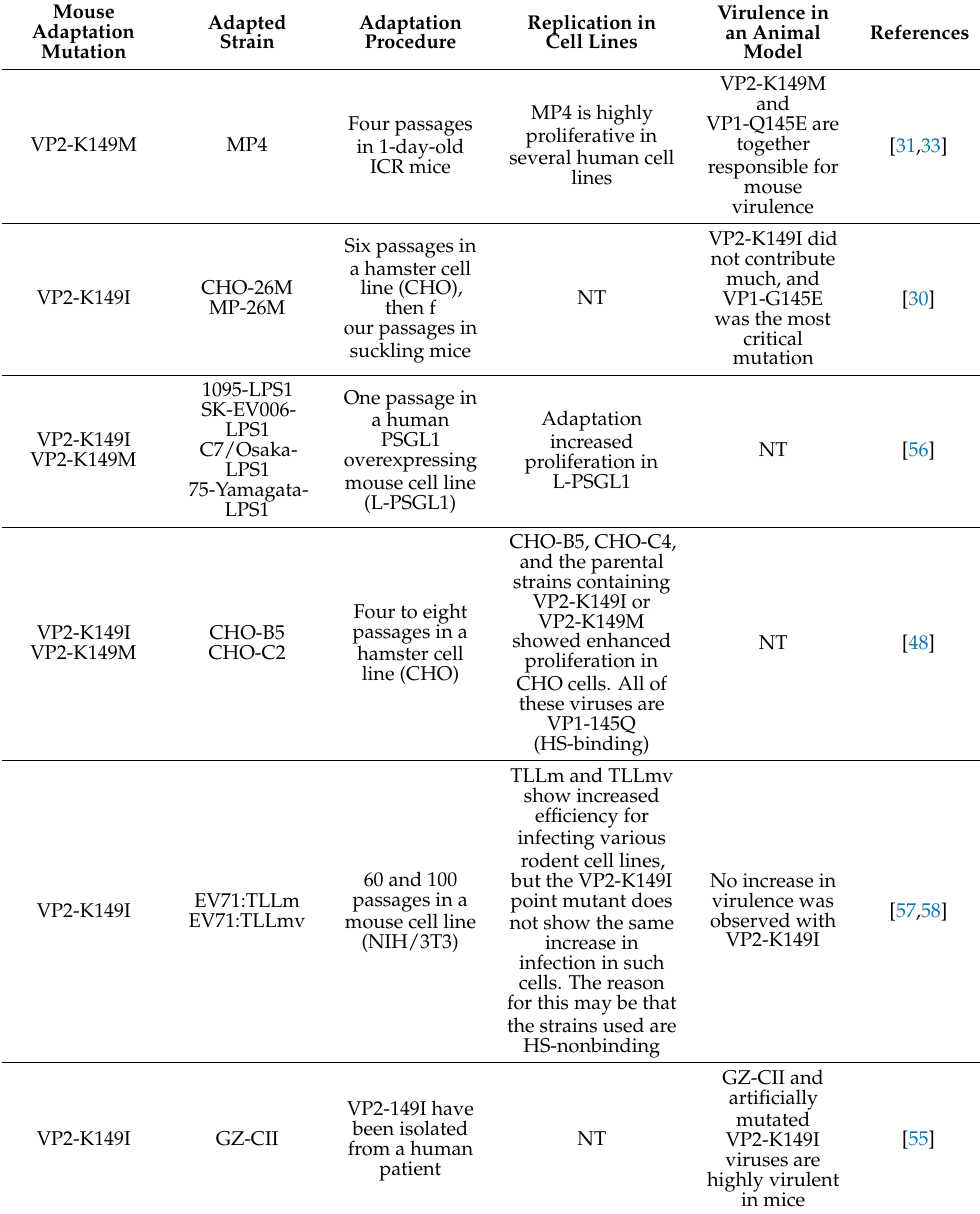
Table 2. Studies on mouse